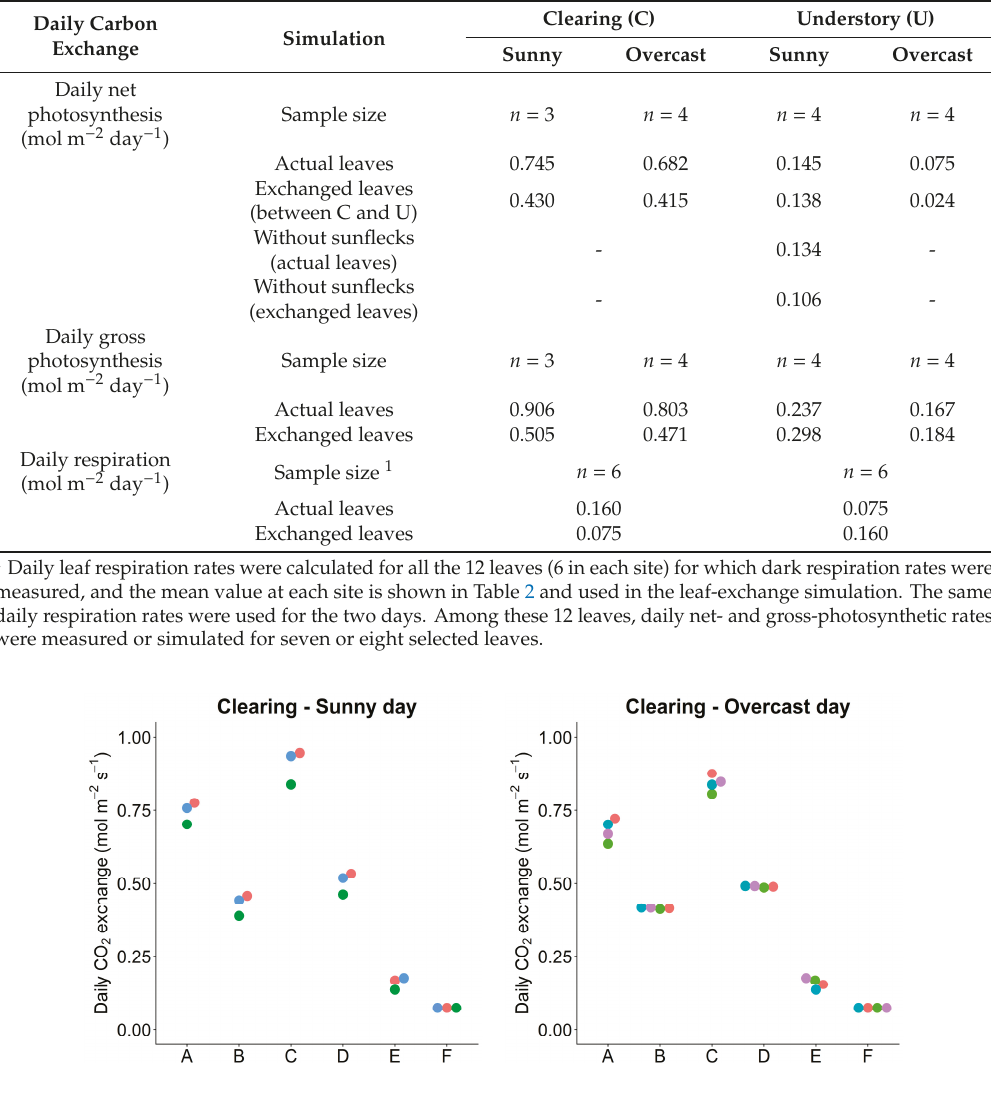
Table 2. Daily carbon exchange per unit area of leaf. The mean value for each item is shown.